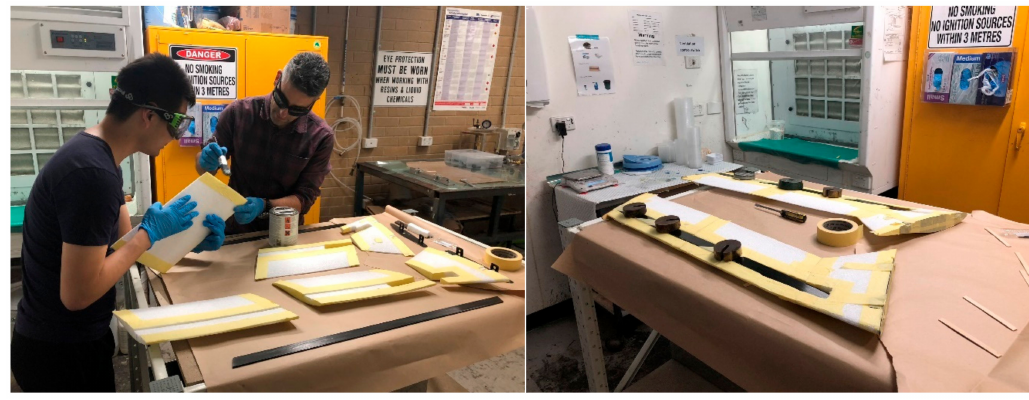
Figure 9. Process of wing and beam bonding.